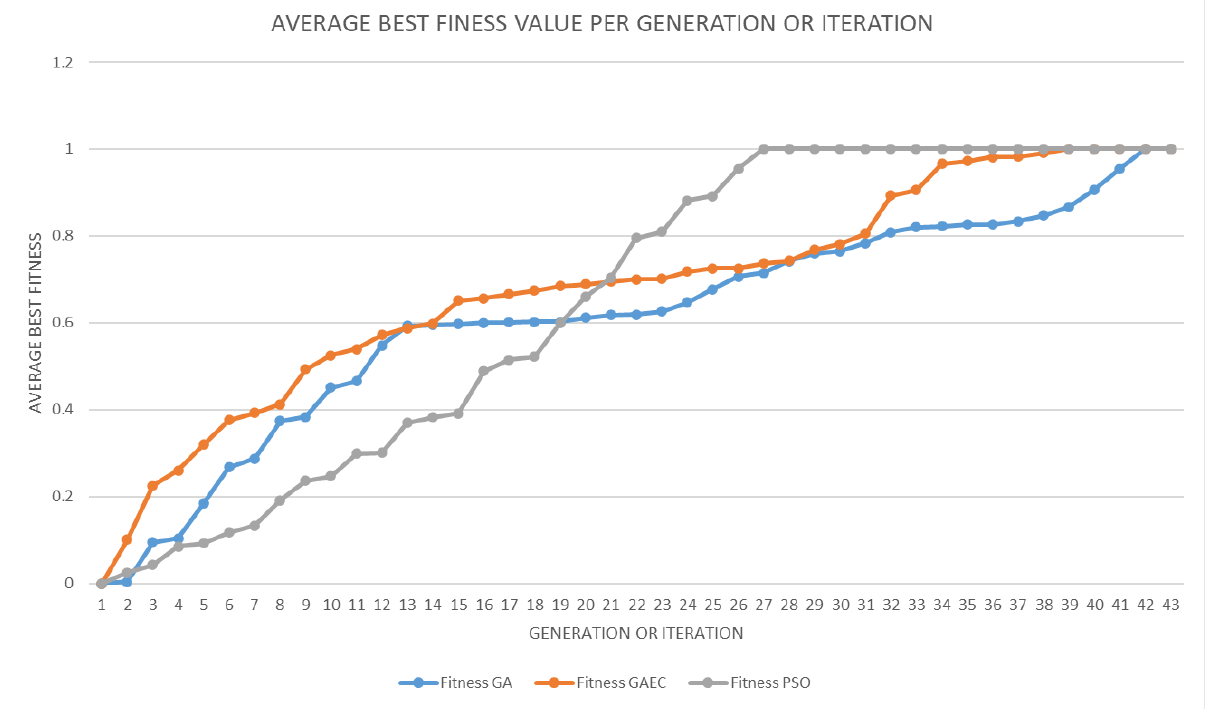
Figure 8. Average best fitness value per generation or iteration.